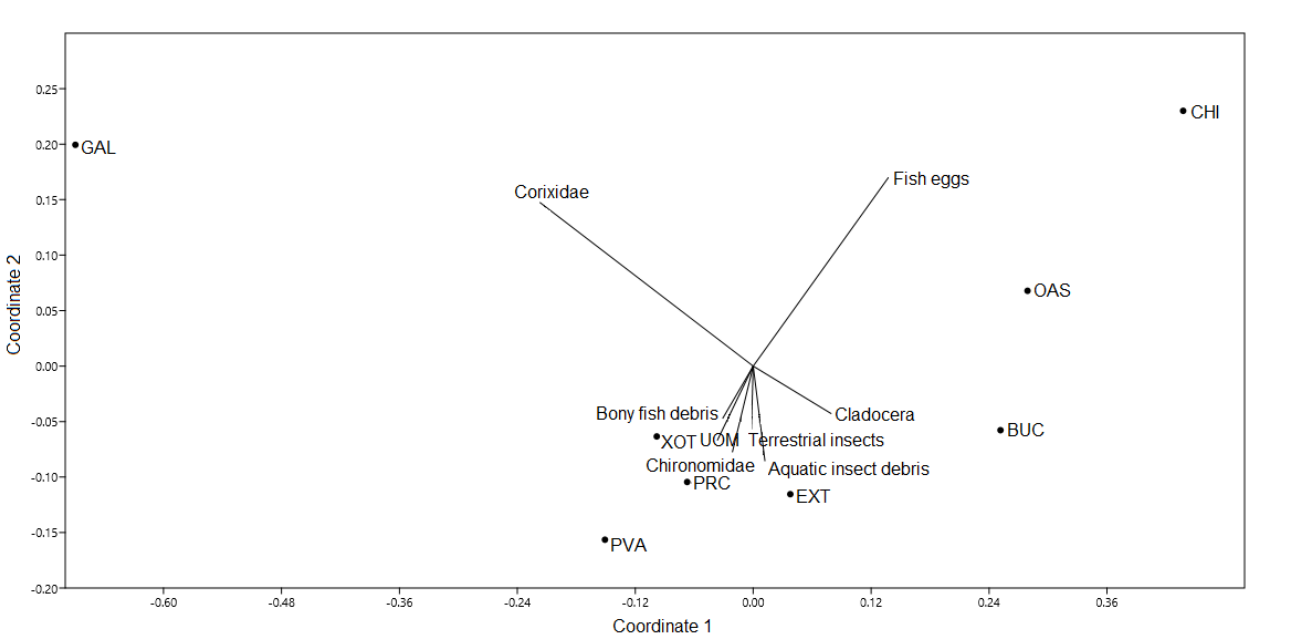
FIGURE 4 | Non-metric multidimensional scaling based on IRI scores of food items of the diet of Pseudoxiphophorus bimaculatus and the IIBAMA, FBI and VBHA scores of the study sites. Stress = 0. Coordinate 1, r 2 = 0.9782; Coordinate 2, r 2 = 0.2477. XOT = El Xote; CHI = El Charco del Ingenio; GAL = Los Galvanes; PRC = Presa del Carmen; PVA = Paso de Vaqueros; OAS = Oasis; EXT = Extoraz; BUC =